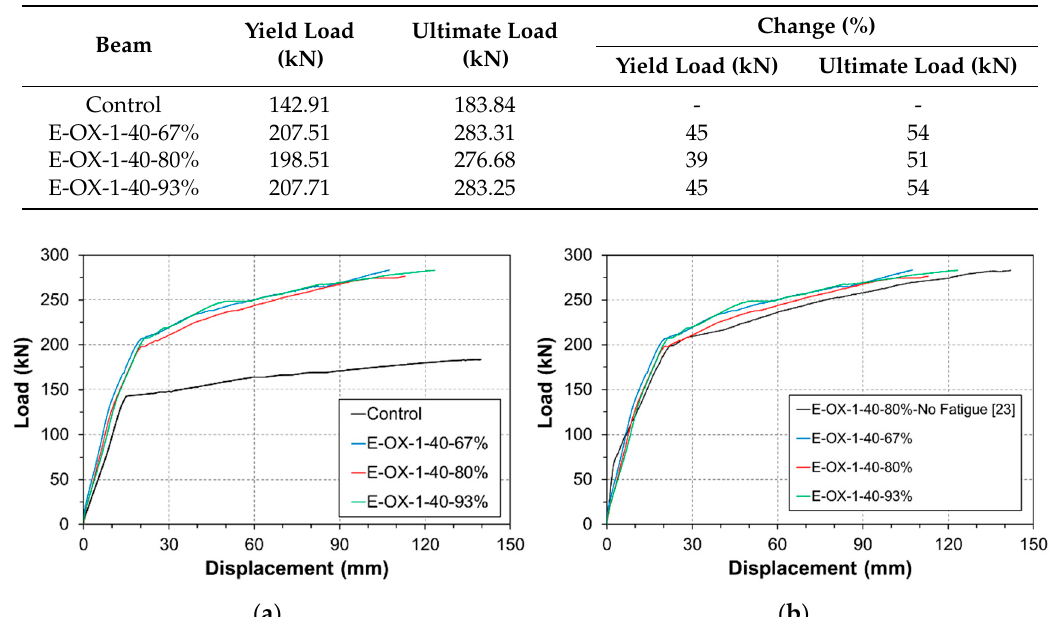
Table 6. Experimental results of NSM-strengthened RC beam (Bond Length).